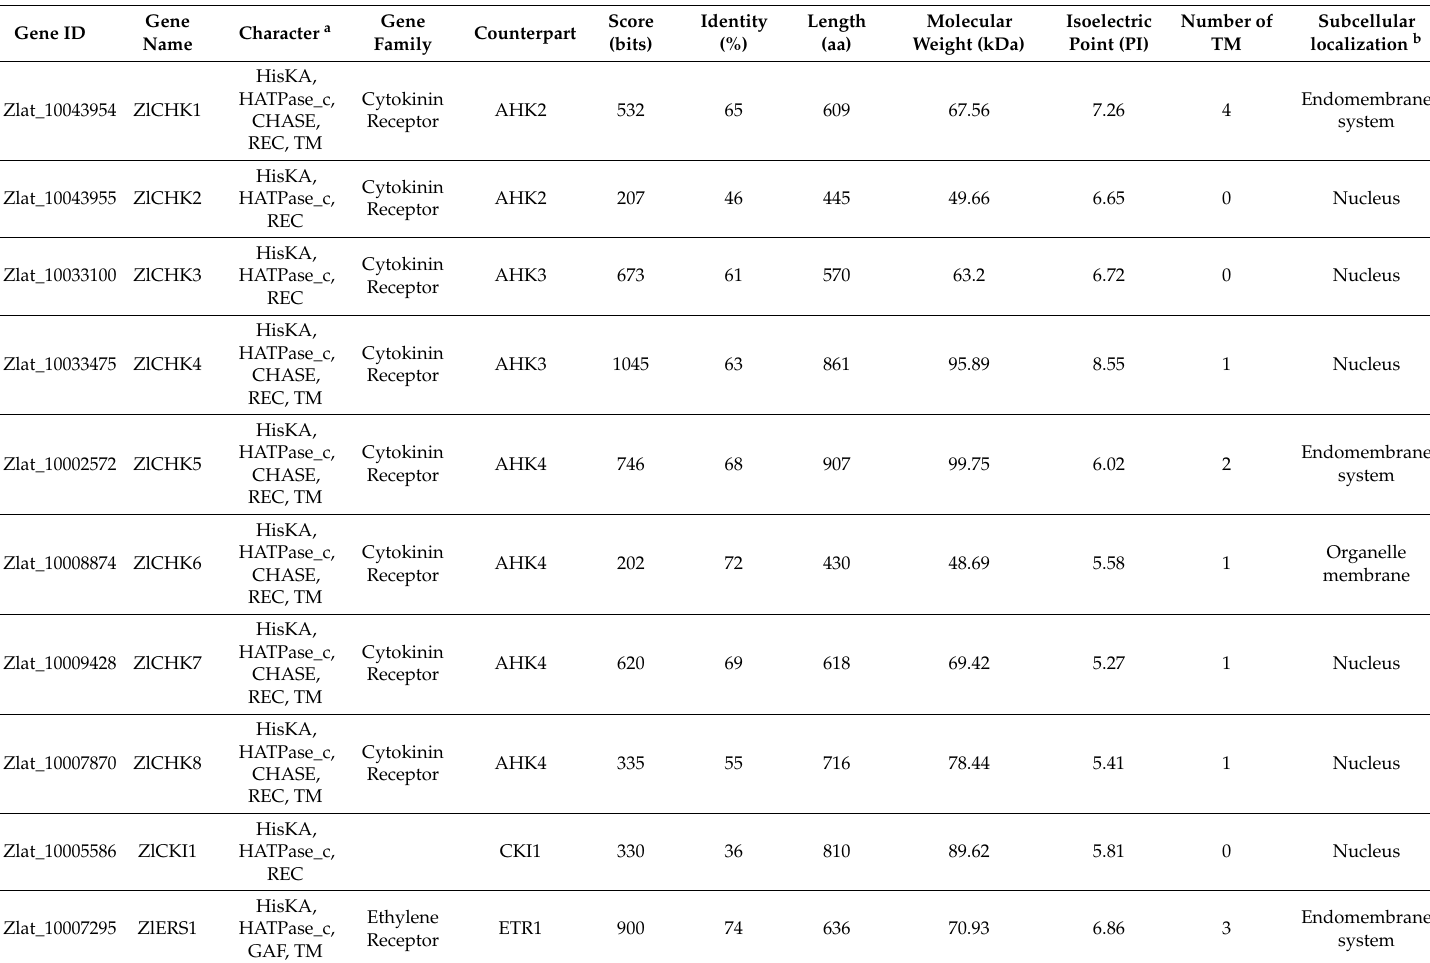
Table 1. Histidine kinase / histidine-kinase-like (HK(L)) proteins in Z. Latifolia